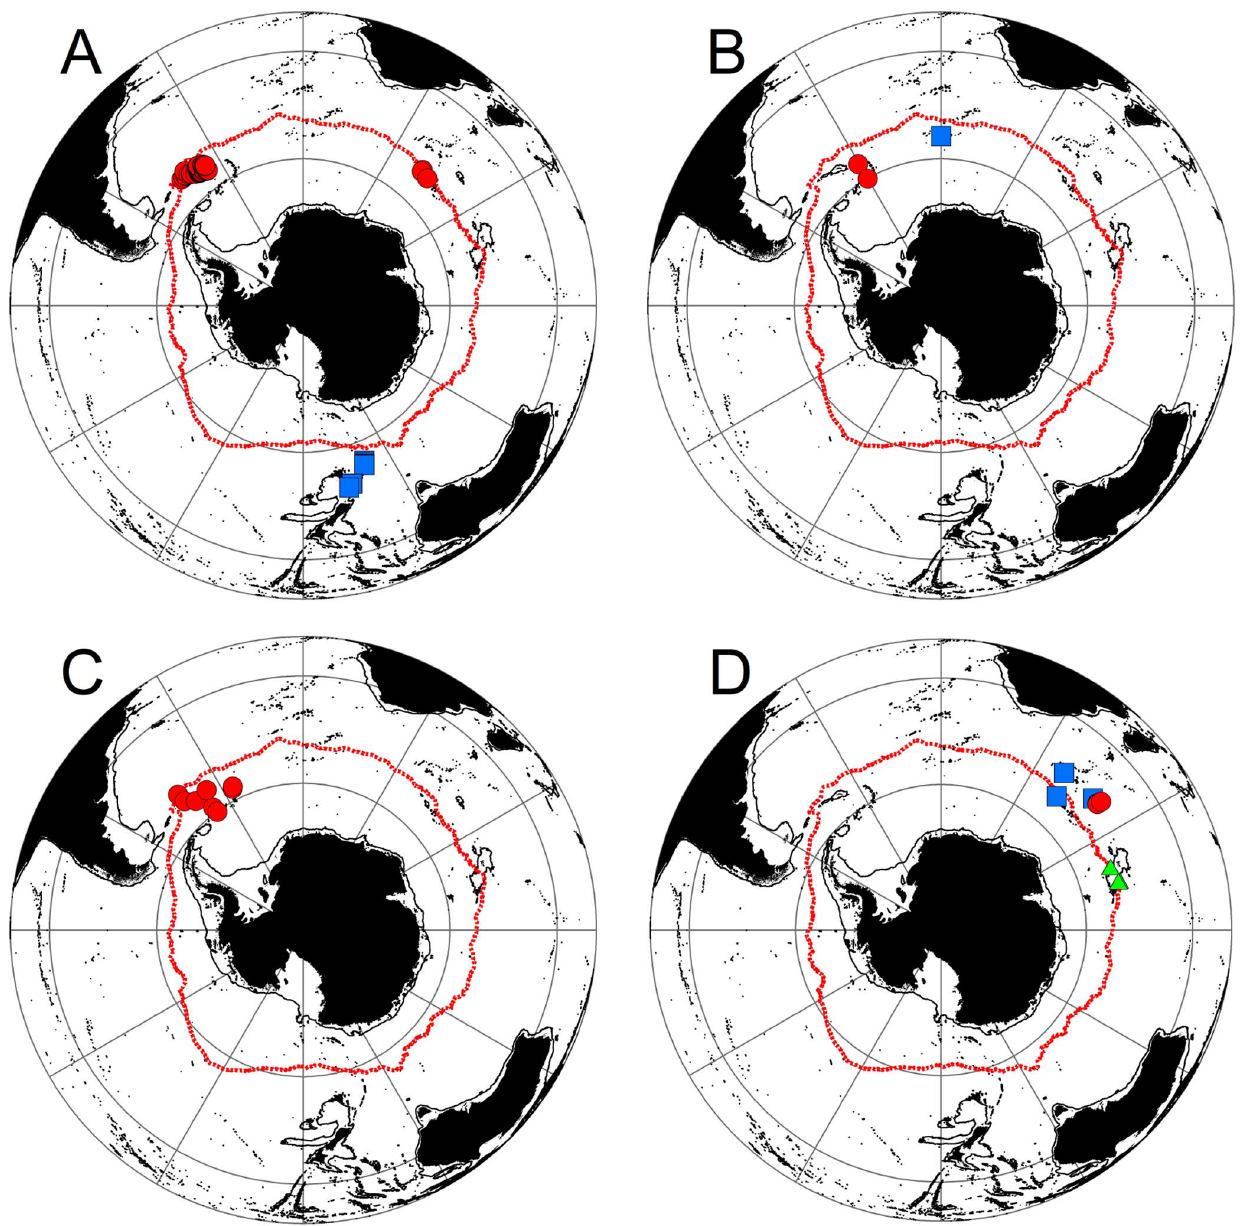
Figure 5. Southern Ocean crabs and lobsters with distributions south of the sub-Antarctic Front. Paralomis anamerae (A – Red circle), Lithodes macquariae (A – Blue square), Kiwa sp . (B – Red circle), Paralomis elongata (B – Blue square), Thymopsis nilenta (C), Thymopides grobovi (D – Green triangle), Paralomis aculeata (D – Blue squares) and Neolithodes duhameli (D – Red circle). Red line=Mean position of Polar Front (Moore et al., 1999).